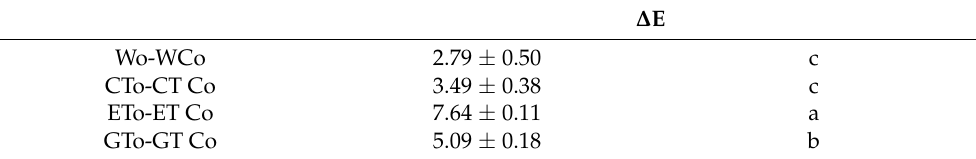
Table 8. Oxidation effect on Δ E.